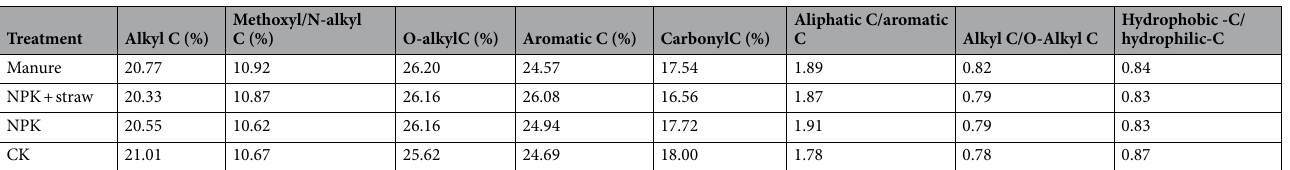
Table 1. Relative percentages of functional groups with different chemical shift intervals in the CPMAS13C- NMR spectra in humic acid of red soil under fertilization treatments. Alkyl-C, Methoxyl/N-alkyl-C, O-alkyl-C, Aromatic-C and Carbonyl-C were identified with chemical shift of 0–45, 45–60, 60–110, 110–160, and 160–220 ppm, respectively. Aliphatic C/Aromatic C = (Alkyl C + O-alkyl C)/Aromatic C; Hydrophobic-C/